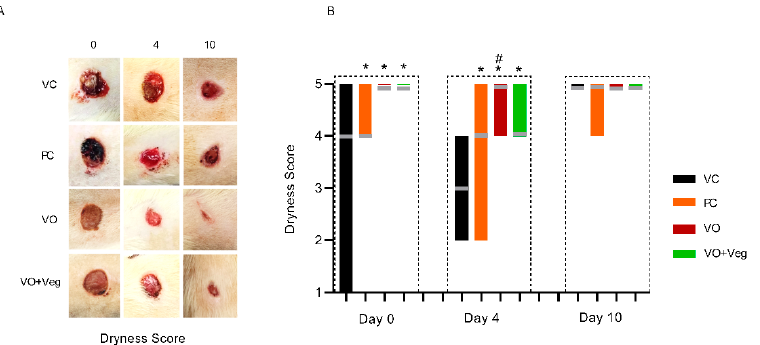
Figure 4. Typical images of dryness in respective groups and treatment evaluation time ( A ). Graph of dryness scores in VC, PC, VO, and VO + Veg groups, in three periods of evaluation. The bars represent the data dispersion (minimum and maximum), and the horizontal gray lines represent mode ( B ). * p < 0.05: VO vs. VC; # p < 0.05: VO vs. PC.